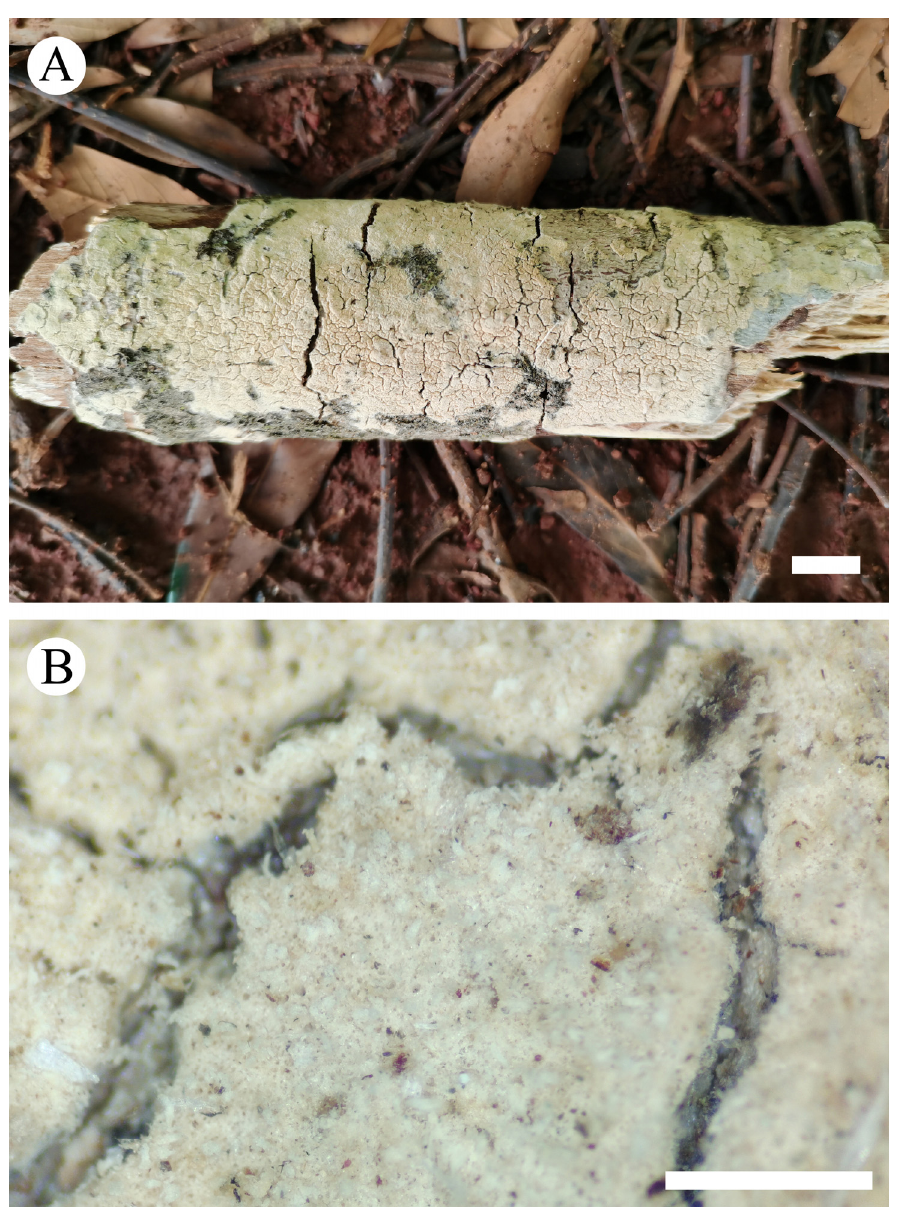
Figure 6. Basidiomata of Xylodon macrosporus (holotype). Bars: a = 1 cm and b = 1 mm. Hymenium— Cystidia of three types: (1) capitate cystidia rare, smooth, colorless, thin-walled, slightly constricted at the neck, with a globose head, 8–25.5 × 3–10 µm; (2) cylindrical cystidia numerous, strongly encrusted in the obtuse apex, 44–79.5 × 3–6 µm; (3) cystidia frequently, smooth, colorless, thin-walled, 11–21 × 6–11 µm; basidia subcy- lindrical, with 4 sterigmata and a basal clamp connection, 11.5–36 × 5–11 µm. IKI–, CB–, 8–10.5(–11) × (7–)7.5–9(–9.5) µm, L = 9.25 µm, W = 8.14 µm, Q = 1.07–1.15 ( n =